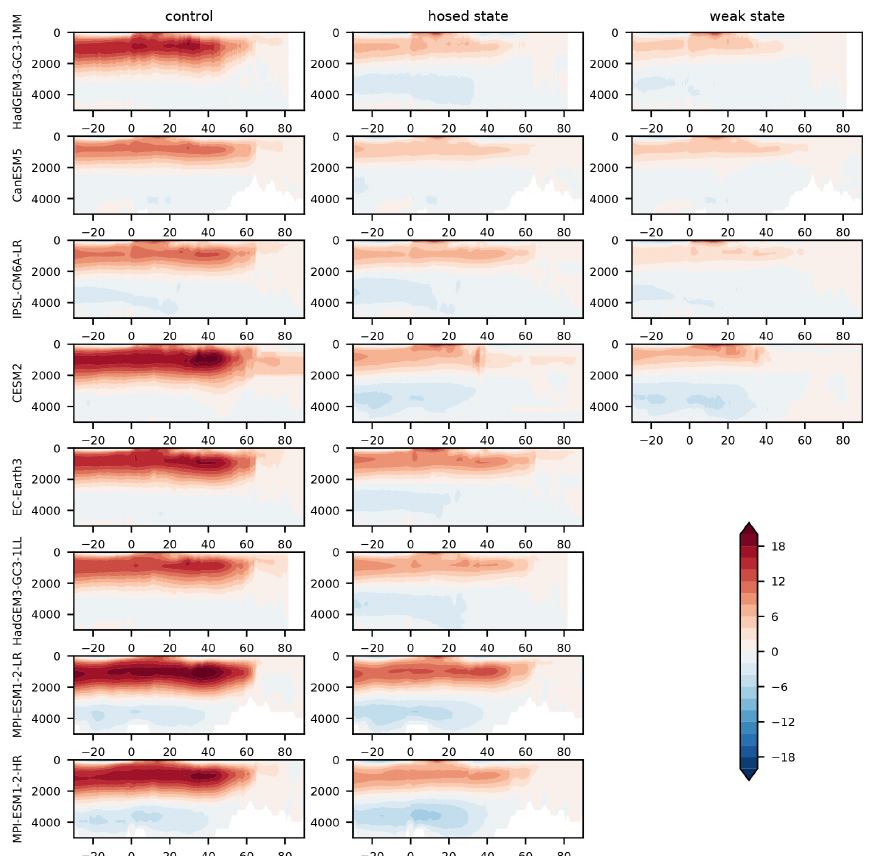
Figure 2. Time mean stream functions (Sv). Each row shows AMOC stream functions from different models. The first column shows the control, the second column shows years 40–50 of u03-hos, and the third column shows years 50–100 of the recovery experiments where the AMOC stays weak. For HadGEM3-GC3-1MM and CESM2, this is experiment u03-r50; for IPSL-CM6A-LR, this is experiment u03-r100; and for CanESM5, this is experiment